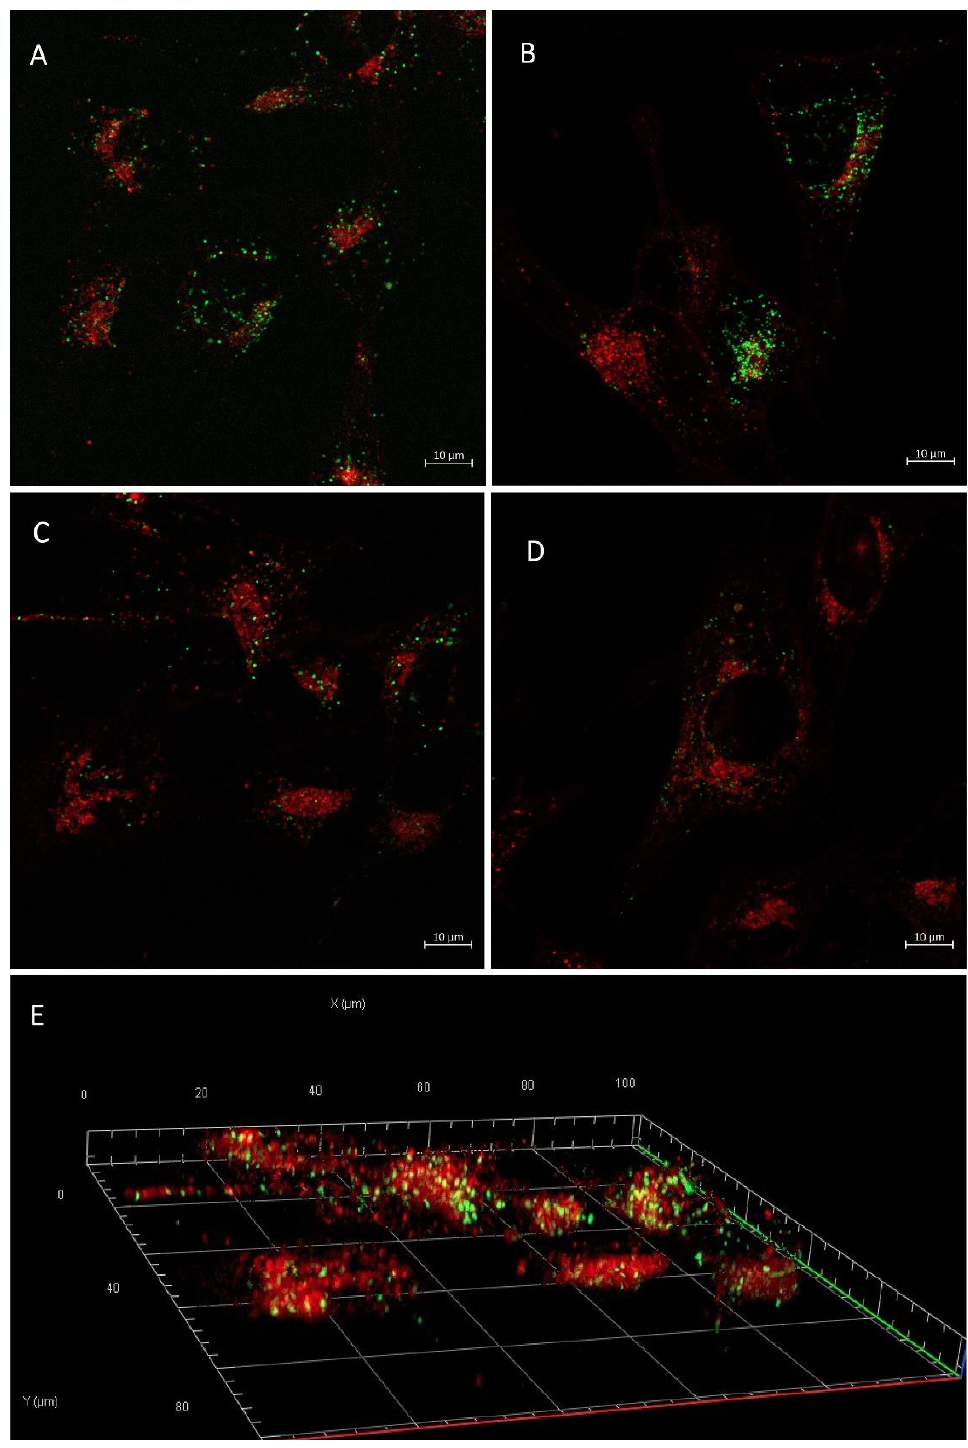
Figure 4. Confocal microscopy images of calcein uptake in GL261 cells after 4 h of incubation. ( A ) pH-Lip, ( B ) pH-Lip–PEG750, ( C ) pH-Lip–PEG2000, ( D ) Lip, ( E ) pH-Lip–PEG2000 in 3D representation of z-stack images. Green: calcein; Red: WGA640. pH-Lip: pH-responsive liposomes without PEG, pH-Lip–PEG750: pH-responsive with DSPE-PEG750, pH-Lip–PEG2000: pH-responsive with DSPE-PEG2000, Lip: non-pH-responsive, non-PEGylated liposomes.